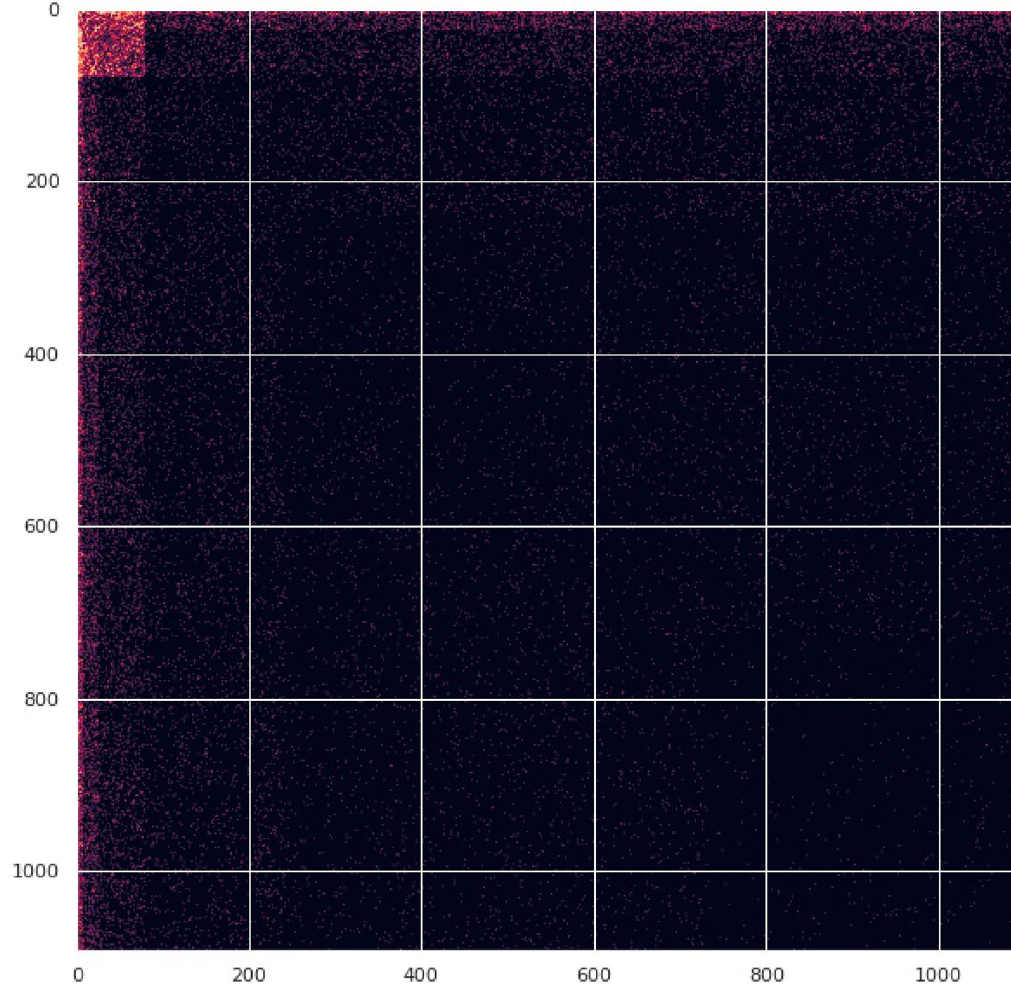
Figure 3. Adjacency matrix of IGAM2 model with c 1 = 1.5, c 2 = 2.5, b = 3 , H 0 = 2 and H = 6